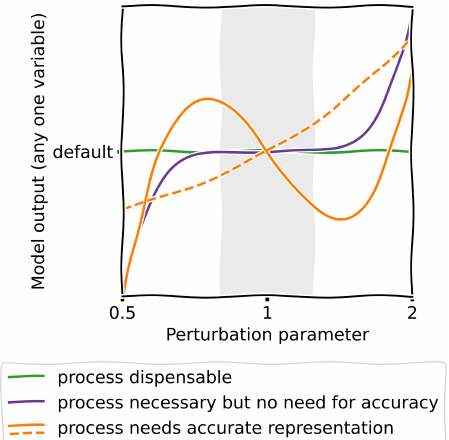
Figure 2. Sketch of the envisioned interpretation. The shading in- dicates the area that is of most interest to judge the effect of process simplifications on the model output. If the slope in this area is small, this suggests that the process can be simplified (green and purple lines). A large slope indicates that the process needs to be repre- sented accurately (orange lines). If no perturbations of the process in the 0.5 to 2 perturbation parameter range and the suppression of the process (perturbation parameter of 0, not shown) have a signif- icant influence on the model output, the process may be removed entirely (green